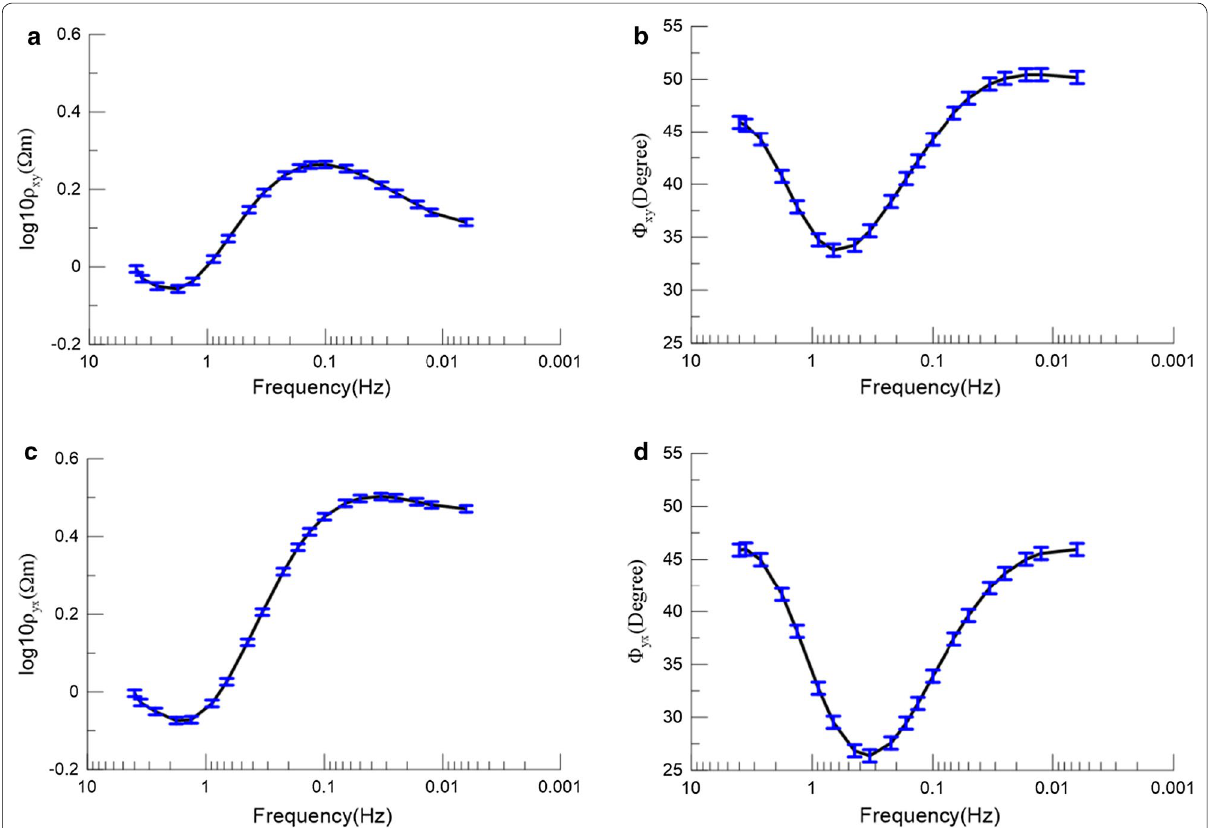
Fig. 8 Synthetic 2D apparent resistivity and phase curves of site 10 for the resistive model: a TE apparent resistivity, b TE phase, c TM apparent resistivity, and d TM phase. Observation errors corresponding to 1% of impedance amplitude are also shown